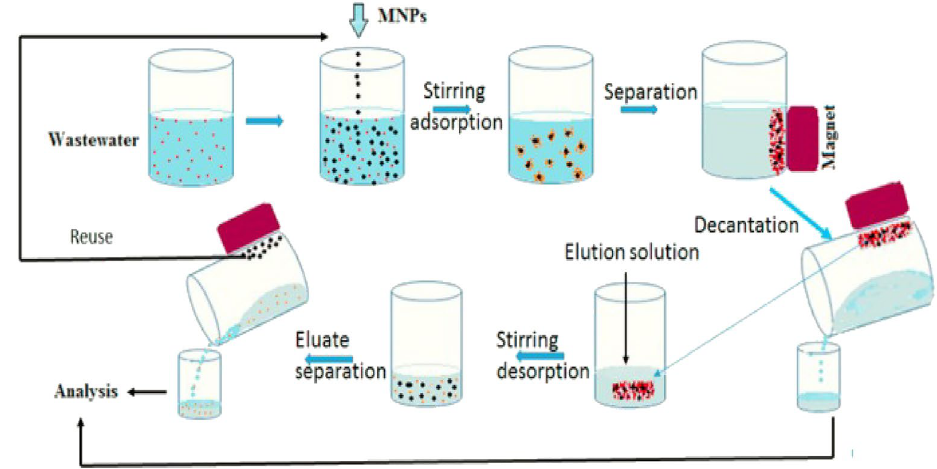
Figure 5. The process of separation of pollutants in the reaction chamber.